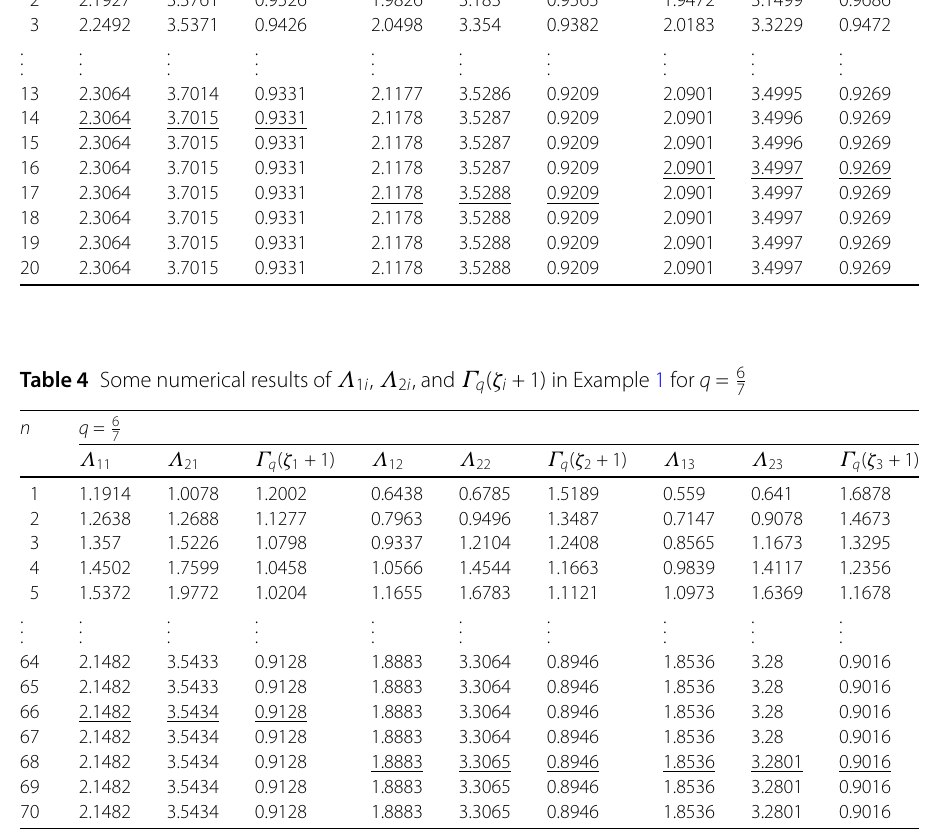
Table 3 Some numerical results of Λ 1 i , Λ 2 i , and Γ q ( ζ i + 1) in Example 1 for q = 1